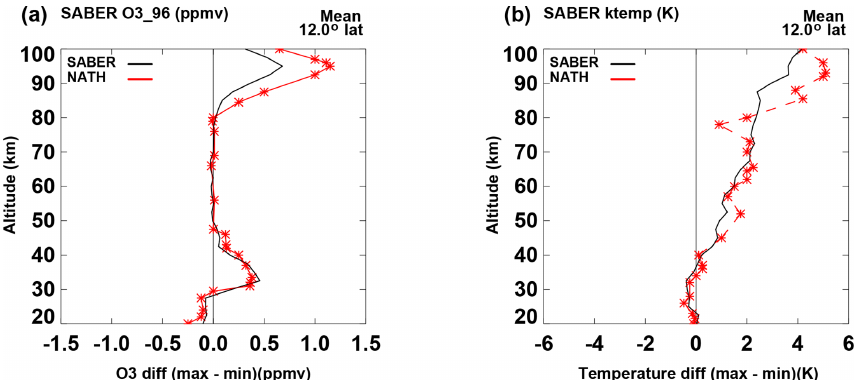
Figure 10. Ozone (a) and temperature (b) responses to solar activity versus altitude from 20 to 100km. Values are responses at solar max minus responses at solar min (in parts per million by volume per 100sfu for ozone and Kelvin per 100sfu for temperature). Black lines denote SABER responses at 12 ◦ latitude; red lines denote results from Nath and Sridharan (2014) for a latitude of 10–15 ◦ , also based on SABER